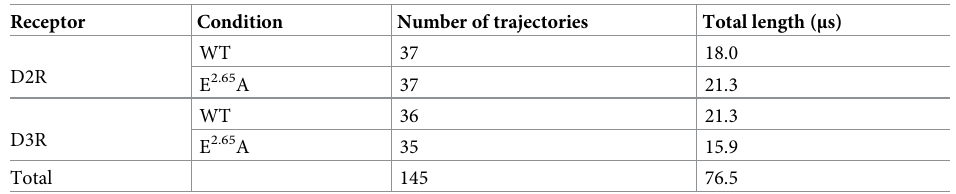
Table 1. Summary of simulated conditions and simulation lengths.